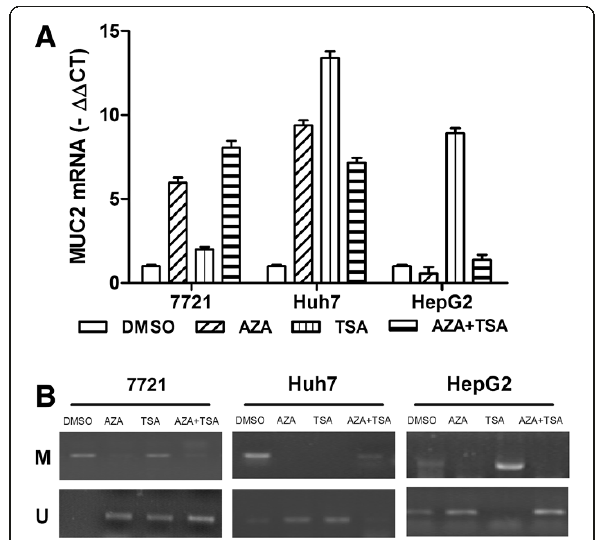
Figure 5 Effect of 5-aza-CdR and TSA on expression of MUC2 transcription in HCC cell lines. ( A ) The MUC2 mRNA was detected by real-time PCR for 7721, Huh7, and HepG2 treated with 5-aza-CdR, TSA, alone or combination. ( B ) It indicated that MUC2 demethylation induced significantly by TSA or TSA in 7721, Huh7 and HepG2